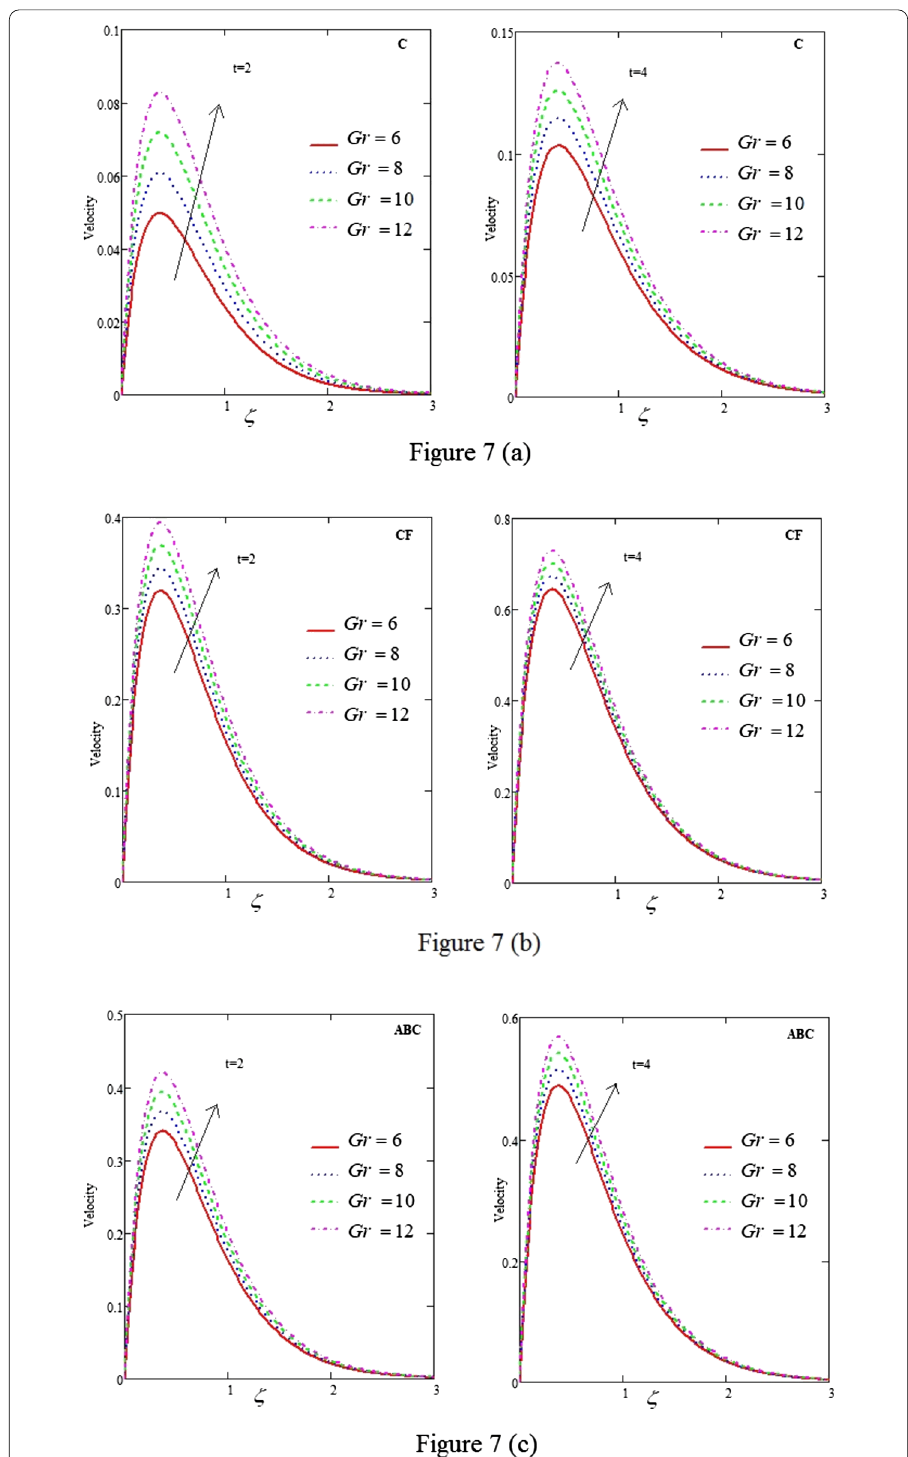
Figure 7 ( a , b , c ). Velocity curves belonging to C, CF and ABC for various values of Gr , where γ = 0.1, Pr = 6, λ = 0.2, Sc = 8, Gm = 8 and M =